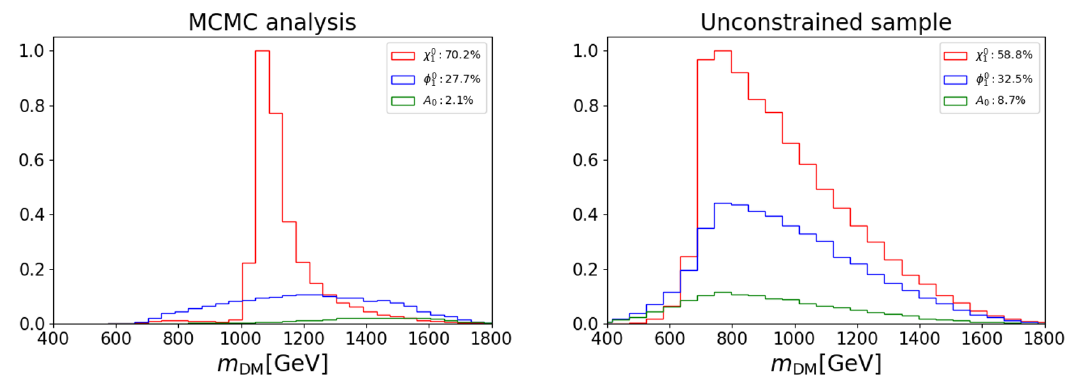
Figure 10 . Distribution of the dark matter mass obtained from the Markov Chain Monte Carlo study imposing the constraints of table 4 (left) and for a random scan using the same parameter intervals but without imposing the constraints (right). The three histograms show the distribution for the three possible dark matter candidates ( χ 0 , φ 0 , A 0 ). The percentages in the legend correspond 1 1 to the relative occurrence of each dark matter